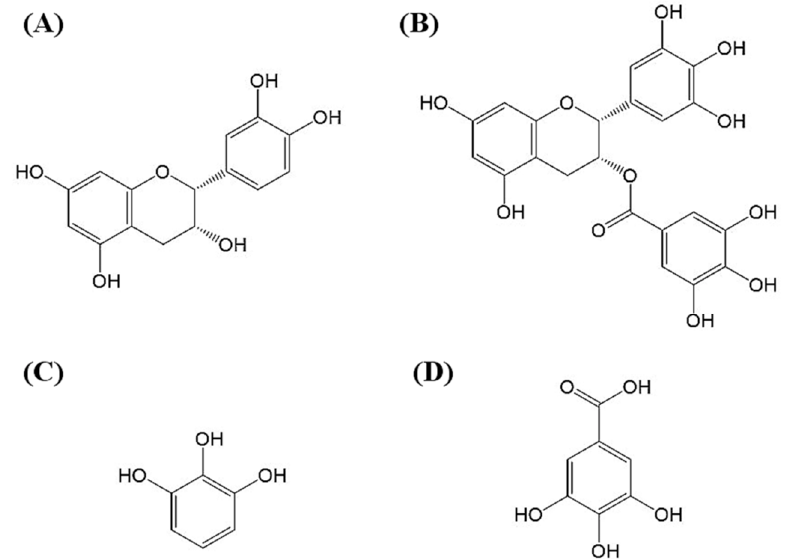
Figure 1. The molecular structures of ( A ) epicatechin (EC), ( B ) epigallocatechin gallate (EGCG), ( C ) pyrogallol (PG), and ( D ) gallic acid (GA).